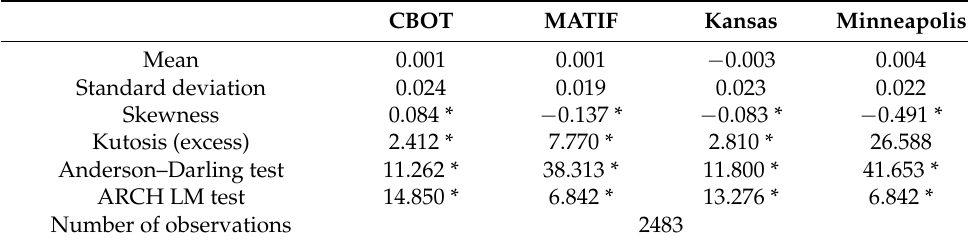
Table 2. Summary statistics first differenced logged price discovery for CBOT, MATIF, Kansas, and Minneapolis.